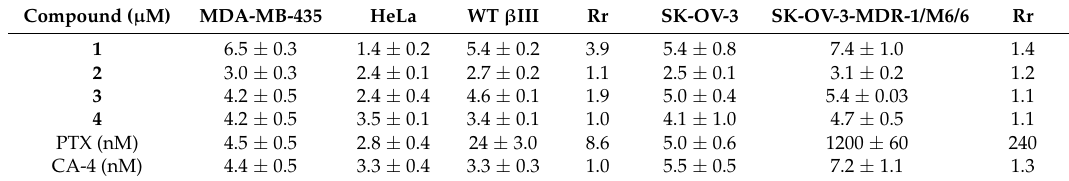
Molecules 2016 , 21 , 1661 8 of 16 Table 1. Antiproliferative effects of the Janus compounds 1 – 4 . The effects of the compounds on the inhibition of cancer cell proliferation were evaluated using the SRB assay in MDA-MB-435 cells and in isogenic pairs of cell lines that are sensitive or resistant to paclitaxel, respectively. The WT β III cell line is a β III-tubulin expressing subline of HeLa and the SK-OV-3-MDR-1/M6/6 is a P-glycoprotein expressing subline of SK-OV-3 cells. The IC 50 (concentration that inhibits growth 50%) values were calculated from the linear portions of log dose–response curves. The relative resistance (Rr) was determined by dividing the IC 50 of the resistant cell line by the IC 50 of the parental cell line for each isogenic cell line pair. Paclitaxel (PTX) and CA-4 were used as positive controls. n = 3 ± SD. Compound ( μ M) MDA-MB-435 HeLa